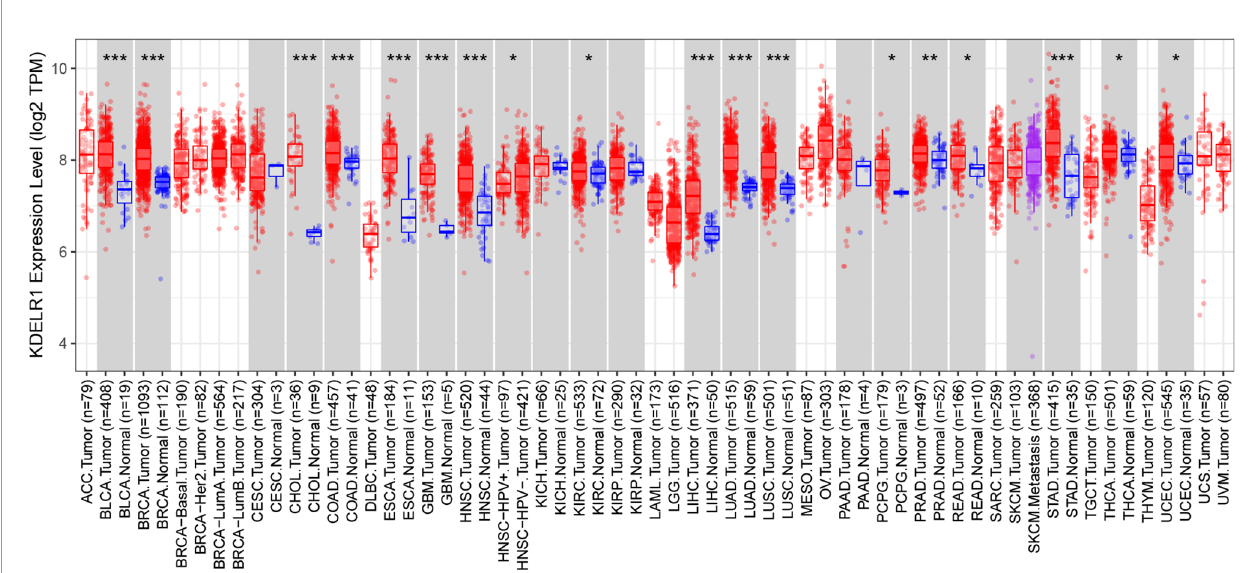
FIGURE 1 | The expression level of KDELR1 is upregulated in GBM. The level of KDELR1 expression in different tumor types from TCGA data analyzed in TIMER. KDELR1 was highly expressed in bladder urothelial carcinoma (BLCA), breast invasive carcinoma (BRCA), cholangiocarcinoma (CHOL), colon adenocarcinoma (COAD), esophageal carcinoma (ESCA), glioblastoma (GBM), head and neck squamous cell carcinoma (HNSC), kidney renal clear cell carcinoma (KIRC), liver hepatocellular carcinoma (LIHC), lung adenocarcinoma (LUAD), lung squamous cell carcinoma (LUSC), pheochromocytoma and paraganglioma (PCPG), prostate adenocarcinoma (PRAD), rectum adenocarcinoma (READ), stomach adenocarcinoma (STAD), thyroid carcinoma (THCA), and uterine corpus endometrial carcinoma (UCEC) tissues and lowly expressed in the positive human papillomaviruses of head and neck squamous cell carcinoma (HNSC-HPV+). *P < 0.05, **P < 0.01, ***P < 0.001.